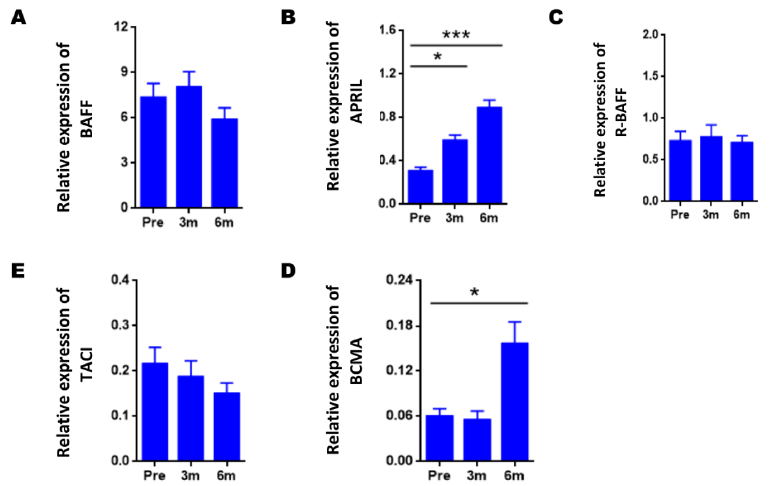
Figure 2. Variation of the gene expression of BAFF, APRIL, and their receptors during post-transplantation. Comparison of the levels of gene expression of BAFF ( A ), APRIL ( B ), R-BAFF ( C ), TACI ( D ), and BCMA ( E ) at three- and six-months post-transplantation vs. pre-transplantation in the total of 40 patients in the pre, 3 m, and 6 m groups. The HPRT gene was used as an endogenous control to normalize BAFF and APRIL gene expression, and the CD19 gene to normalize R-BAFF, TACI, and BCMA gene expression. Expression data were represented as the mean ± SEM. Statistical analyses were performed using the Wilcoxon test for related samples. Values of p < 0.05 were considered significant. * p < 0.05; *** p < 0.001.